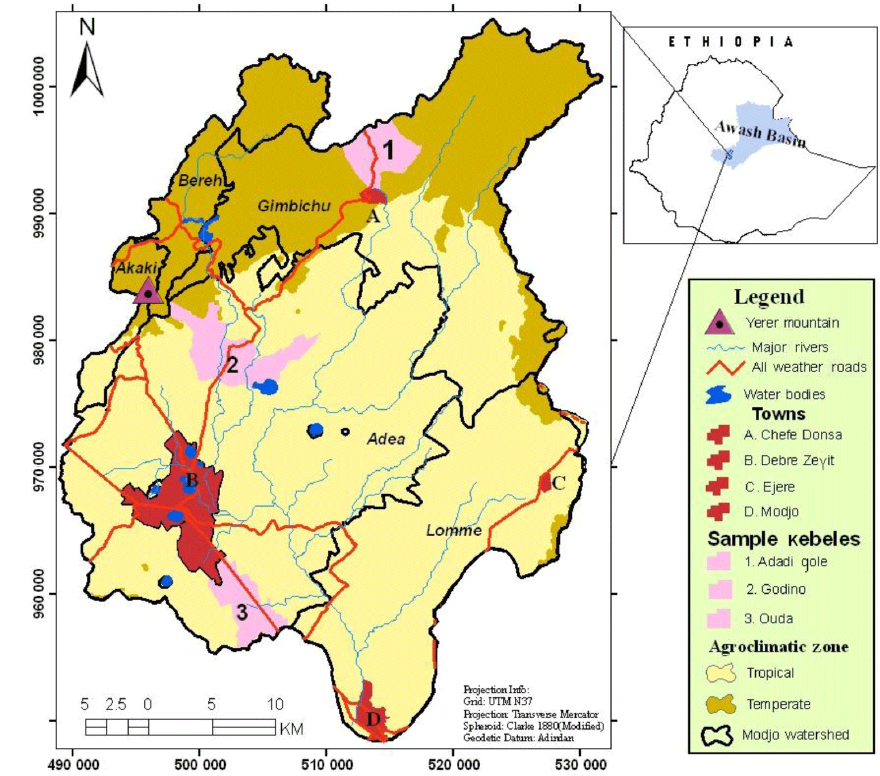
Figure 1. Location map of the Modjo watershed and sample rural kebele